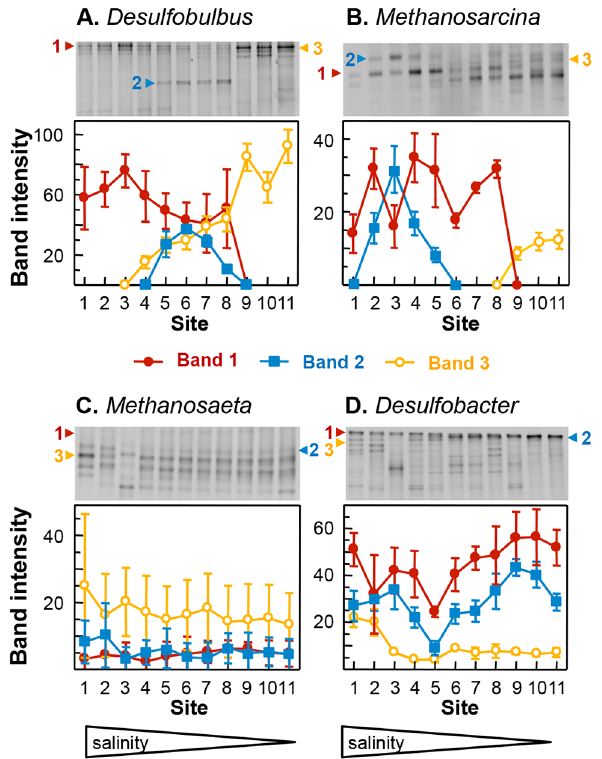
Figure 1. Corrected mean band intensities of representative bands from replicated DNA-DGGE analyses from the 11 sites (from the marine site 1 to the freshwater site 11) along the Colne estuary, Essex, UK for: A. Desulfobulbus , B. Methanosar- cina , C. Methanosaeta and D. Desulfobacter . Numbered arrows on each gel image indicate band numbers. [Band 1 (line with solid circle) Band 2 (line with open square) Band 3(line with open circle)]. Error bars represent the standard error of the mean (SEM, n=3). A complete profile is given in Figure S3.